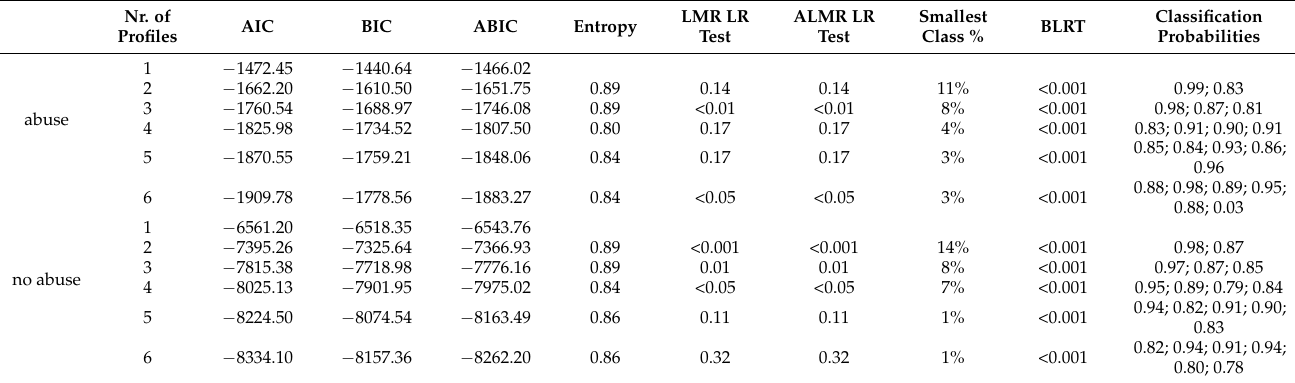
Table 3. Model fit indices for latent profile analysis of adolescents with and without parental physical abuse experience, 1–6